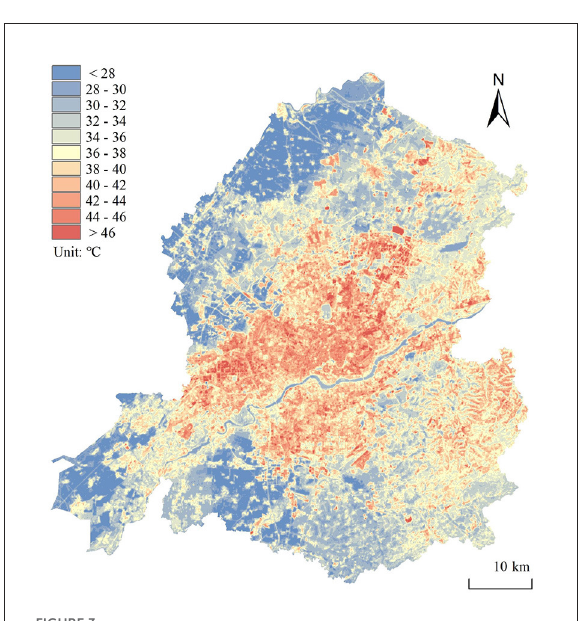
FIGURE3 Land surface temperature distribution.